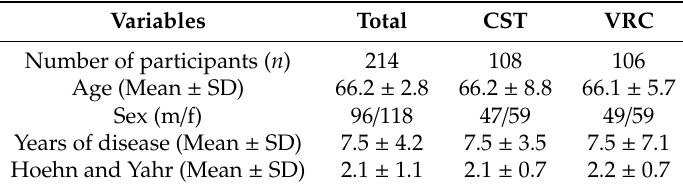
Table 3. Participant characteristics.